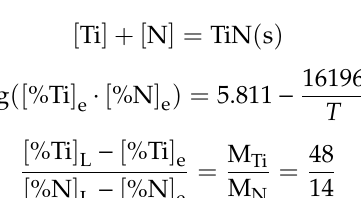
Figure 7. The diagrammatic sketch of N element diffusion in molten steel.